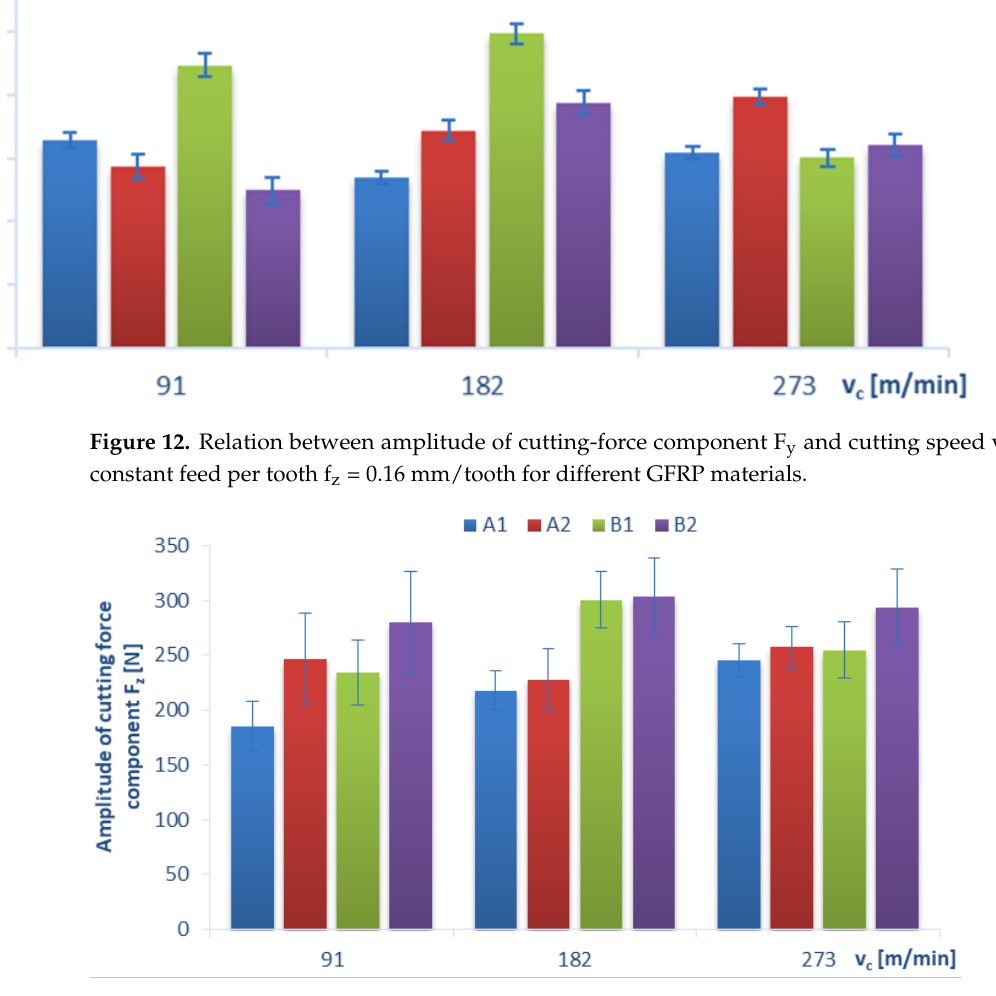
Figure 13. Relationship between the amplitude of cutting-force component F z and the cutting speed v c in a drilling process conducted with a with constant feed per tooth of f z = 0.16 mm/tooth for different GFRP materials.